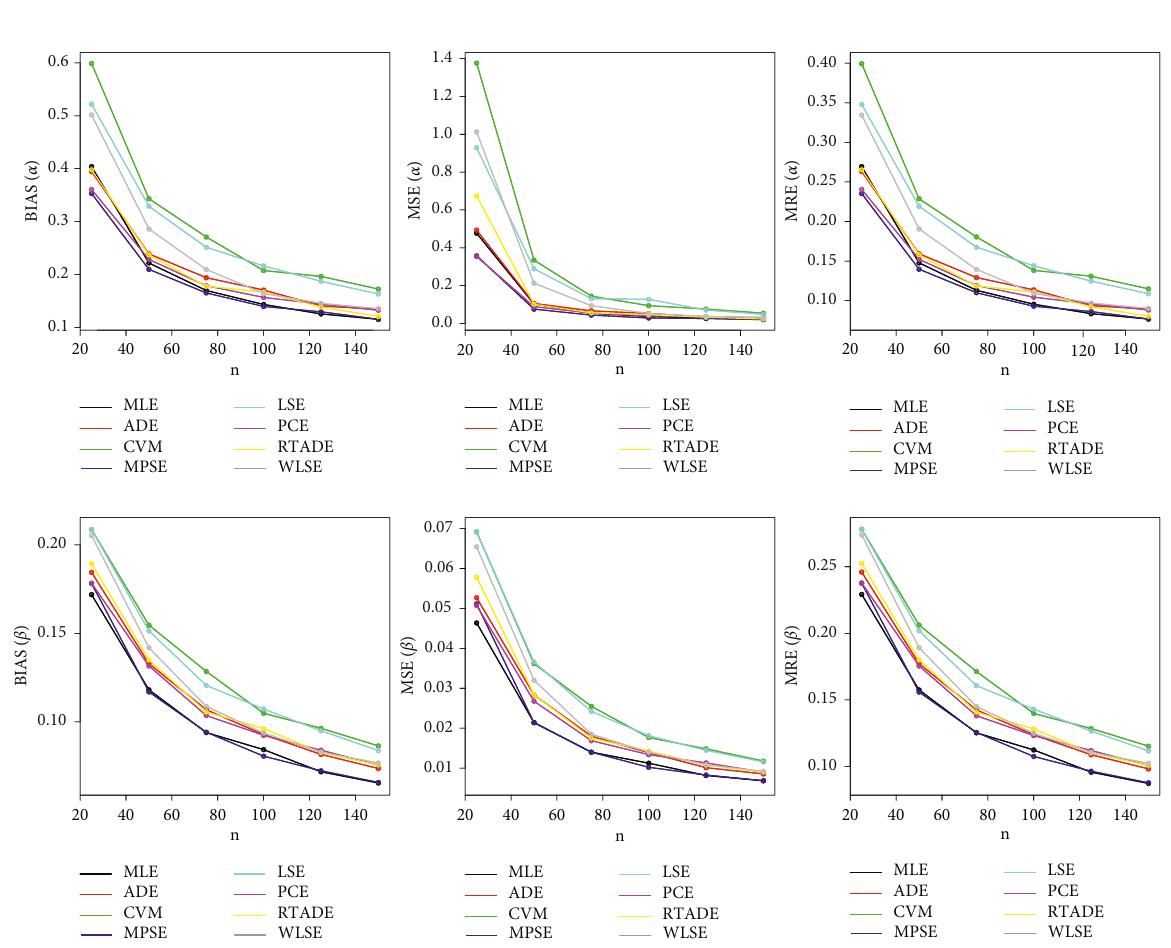
Figure 5: Graphical representation of BIAS, MSE, and MRE values in Table